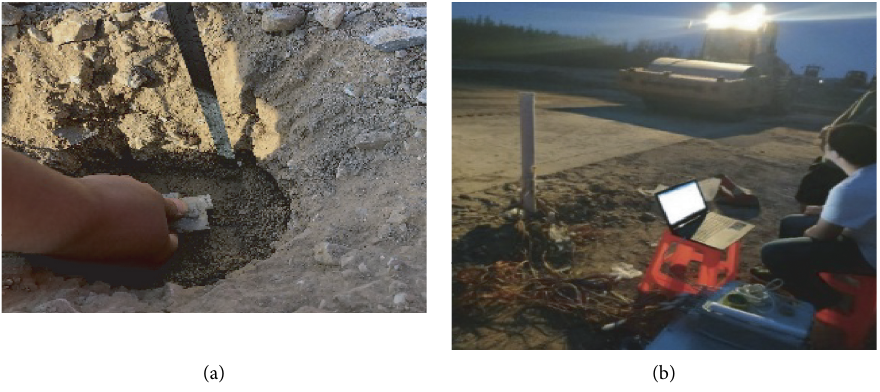
Figure 5: (a) Installation and embedment of sensors and (b) data acquisition in the field test.